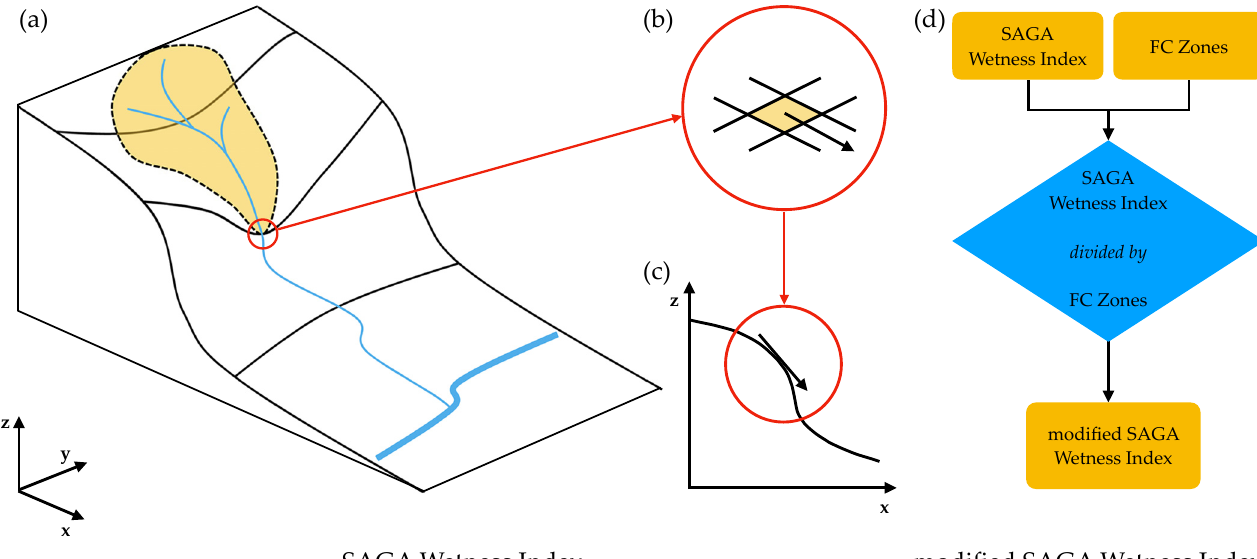
Figure 6. Topographic wetness index: ( a ) flow accumulation area; ( b ) flow direction, and the corresponding flow width for a DEM cell; ( c ) tangent of slope angle; ( d ) custom algorithm for modified SAGA wetness index (( a – c ) adopted from [106], Figure 1, published under CC-BY 4.0 licence).